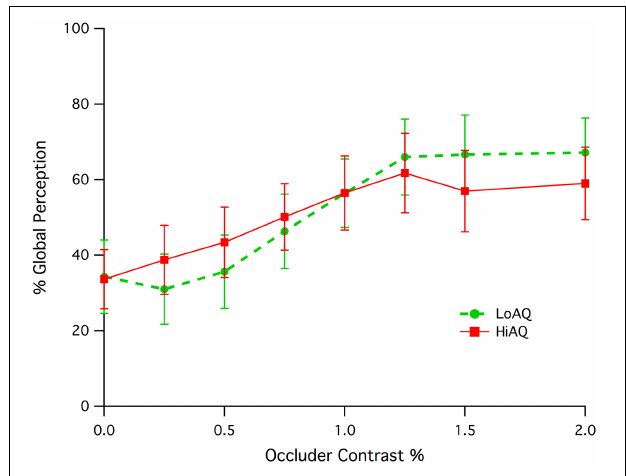
FIGURE 2 | Means and standard error of initial global percept (expressed as a percentage) as a function of occluder contrast for the Low and High AQ